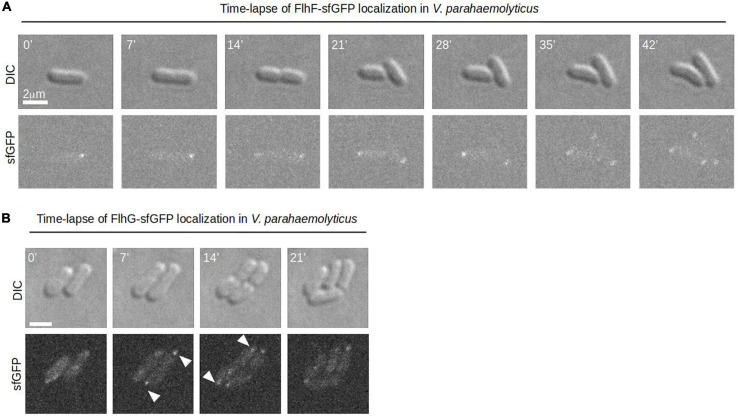
A dynamic spatiotemporal intracellular localization of FlhF and FlhG during the V. parahaemolyticus cell cycle. (A,B) Time-lapse DIC and fluorescence microscopy of V. parahaemolyticus strains expressing (A) FlhF-sfGFP or (B) sfGFP-FlhG fusion proteins. White numbers indicate minutes elapsed.